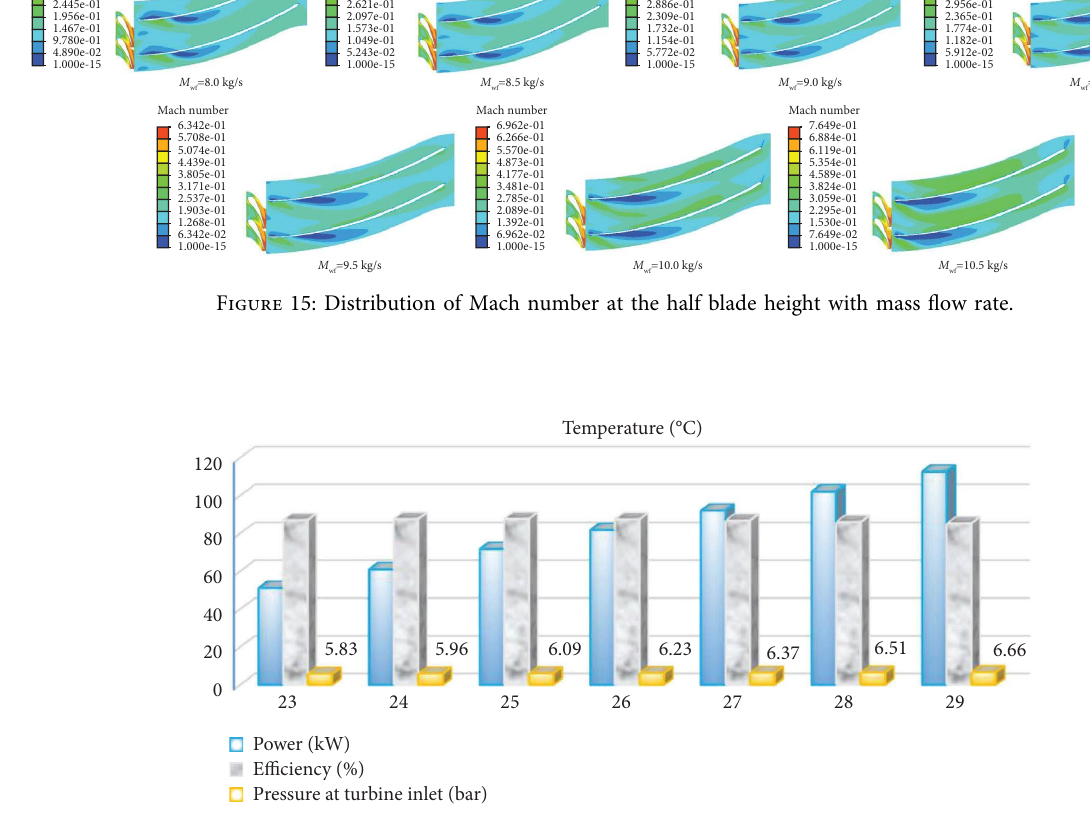
Figure 16: Te infuence of turbine inlet